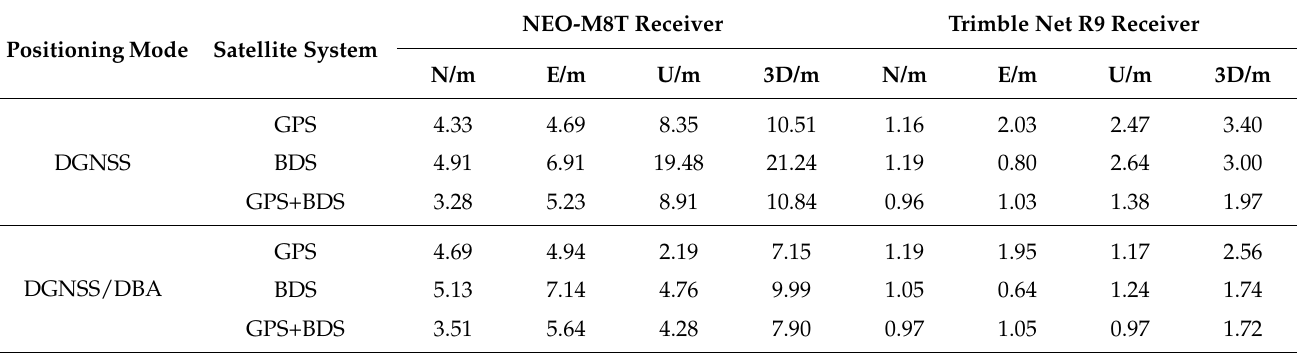
Table 7. The RMSE of bias in the N/E/U directions for low-cost u-blox NEO-M8T and geodetic Trimble Net R9 receivers in the complex urban environment.